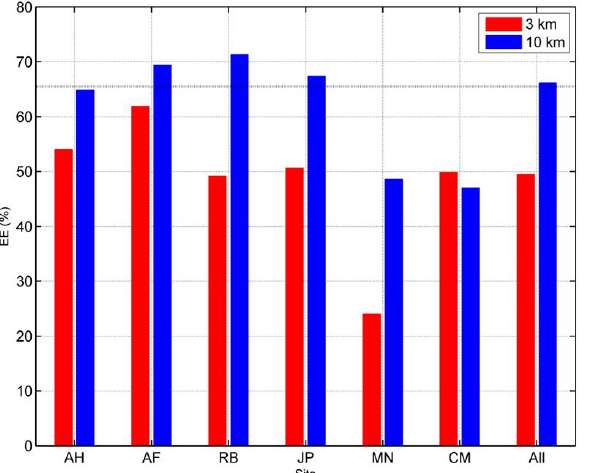
Figure 4. Bar plot showing the percentage of observations that are within the expected error (EE), estimated by the following equation 6 for each site. The dotted line represents the 66% mark, con- sidered the minimum percentage for the product to have a good performance.